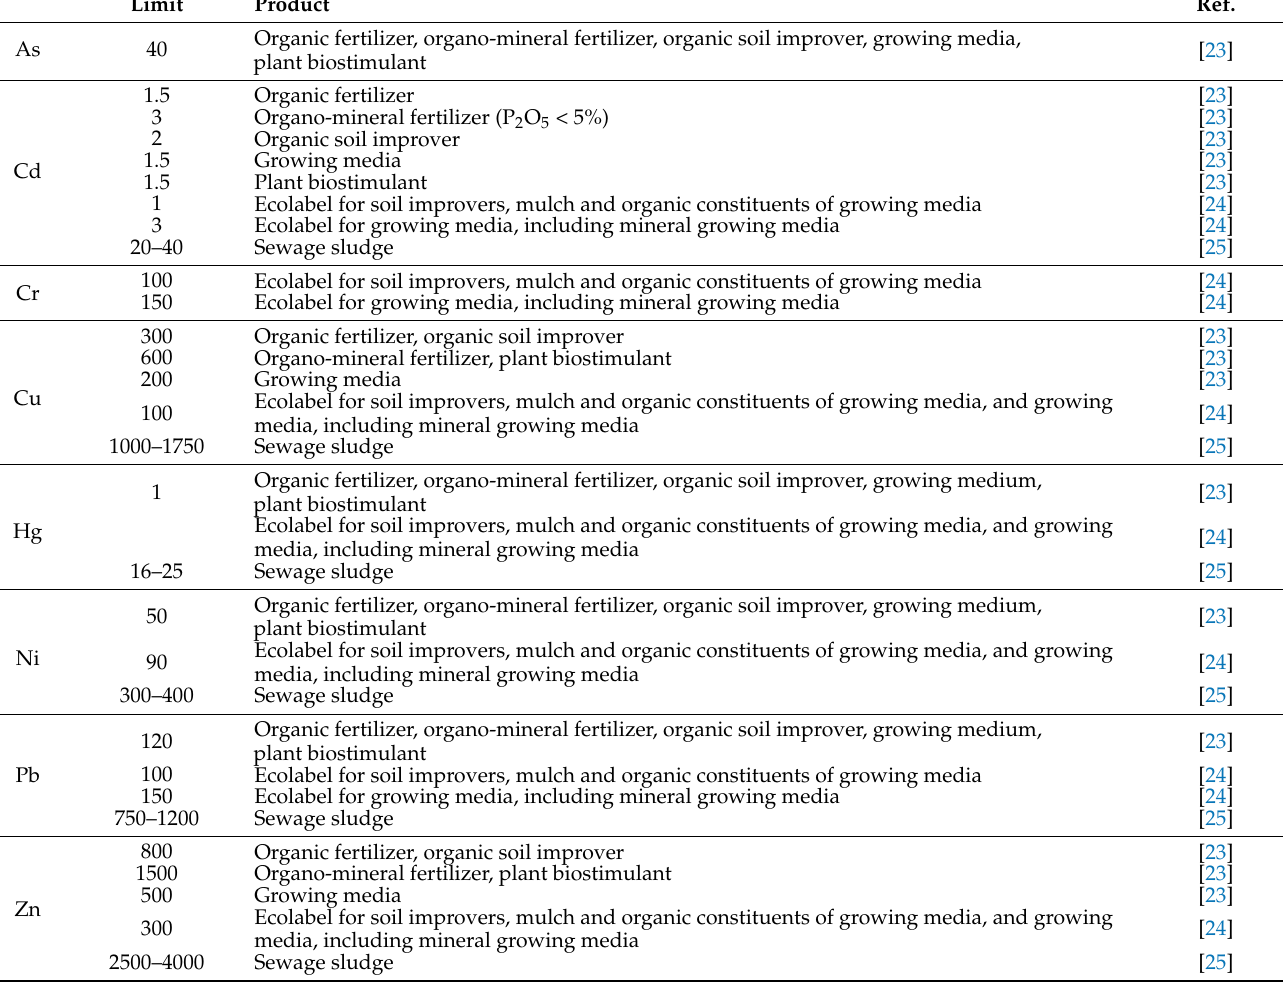
Table 1. Maximum allowable concentrations (mg kg − 1 ) of potentially toxic elements in organic amendments in the European